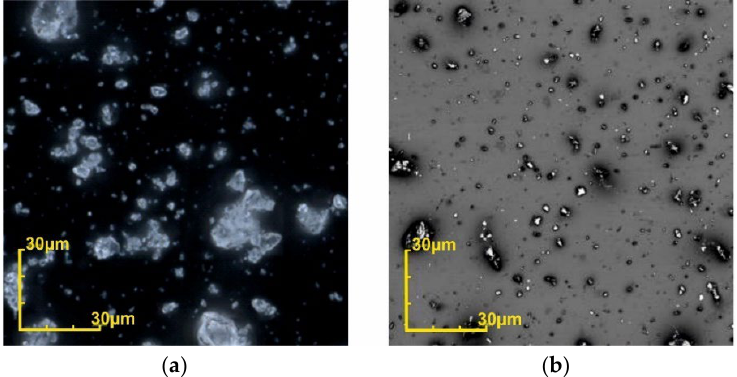
Figure 4. Optical micrographs of ( a ) the 10 µm Almatis Al 2 O 3 and ( b ) the NdFeB powder.